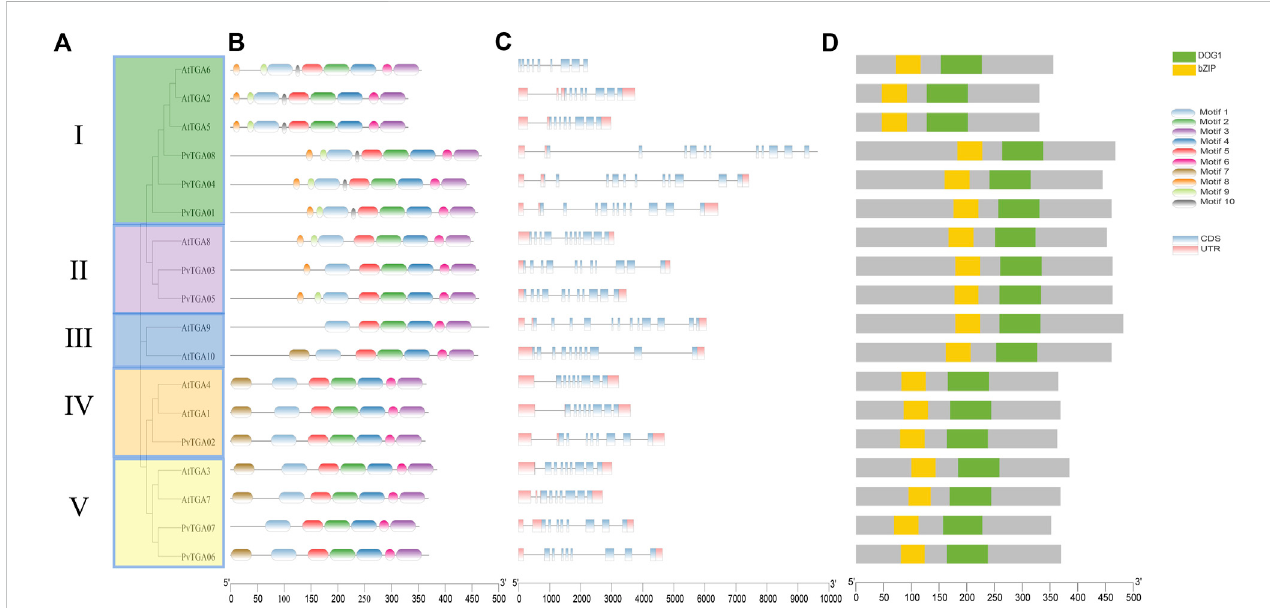
FIGURE 2 Phylogenetic,conservedmotifs andgenestructureofthe TGA genesin P. vulgaris and Arabidopsis . (A) phylogenetictreeoftheTGA proteinsequence in common bean and Arabidopsis species constructed by the Maximum-Likelihood (ML) method. (B) conserved motifs in PvTGAs using MEME-suite. Various colors represented different motifs. (C) the eight common bean TGA gene structures. (D) comparison of conserved domain among AtTGA and PvTGA .The ruler at the bottom indicates length of the